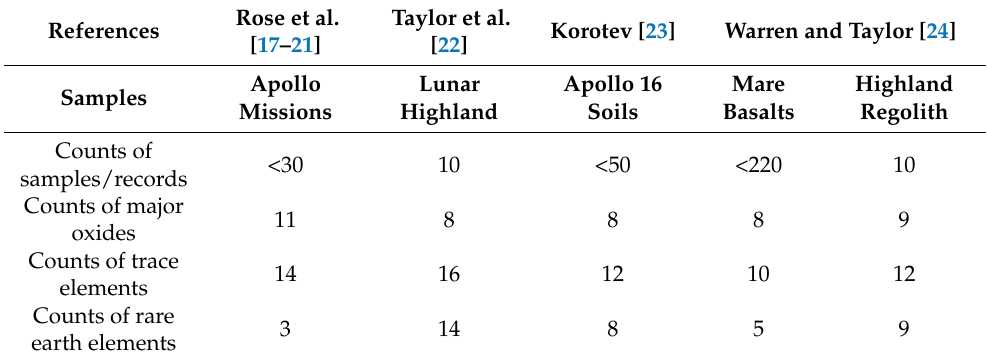
Table 1. Sample counts and element counts of analyzed moon